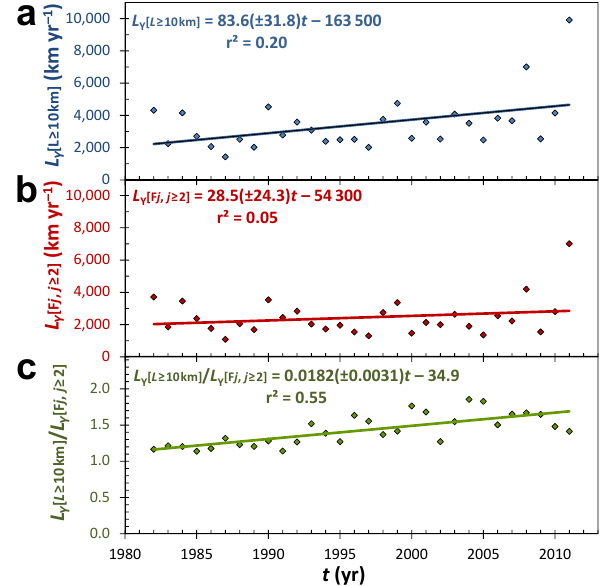
Fig. 8. Continental USA total path length of severe tornadoes per year, L Y , over the time period 1982–2011, using two definitions for severe tornadoes, one path-length based and the other Fujita scale intensity based. Shown is the total path length per year for (a) se- vere tornadoes ( L ≥ 10km), L Y [ L ≥ 10 km ] (F0 to F5 considered), (b) severe tornadoes with Fujita (or Enhanced Fujita) scale inten- sities greater than or equal to F2, L Y [ F j,j ≥ 2 ] , (all path lengths L considered). In (c) is shown, per year, the ratio of (a) to (b) , i.e. L Y [ L ≥ 10 km ] /L Y [ F j,j ≥ 2 ] . In all three panels, the best-fit linear cor- relations are shown, with uncertainties given as ±1s.e. (standard error) of the slope. Tornado path length data L are from NOAA